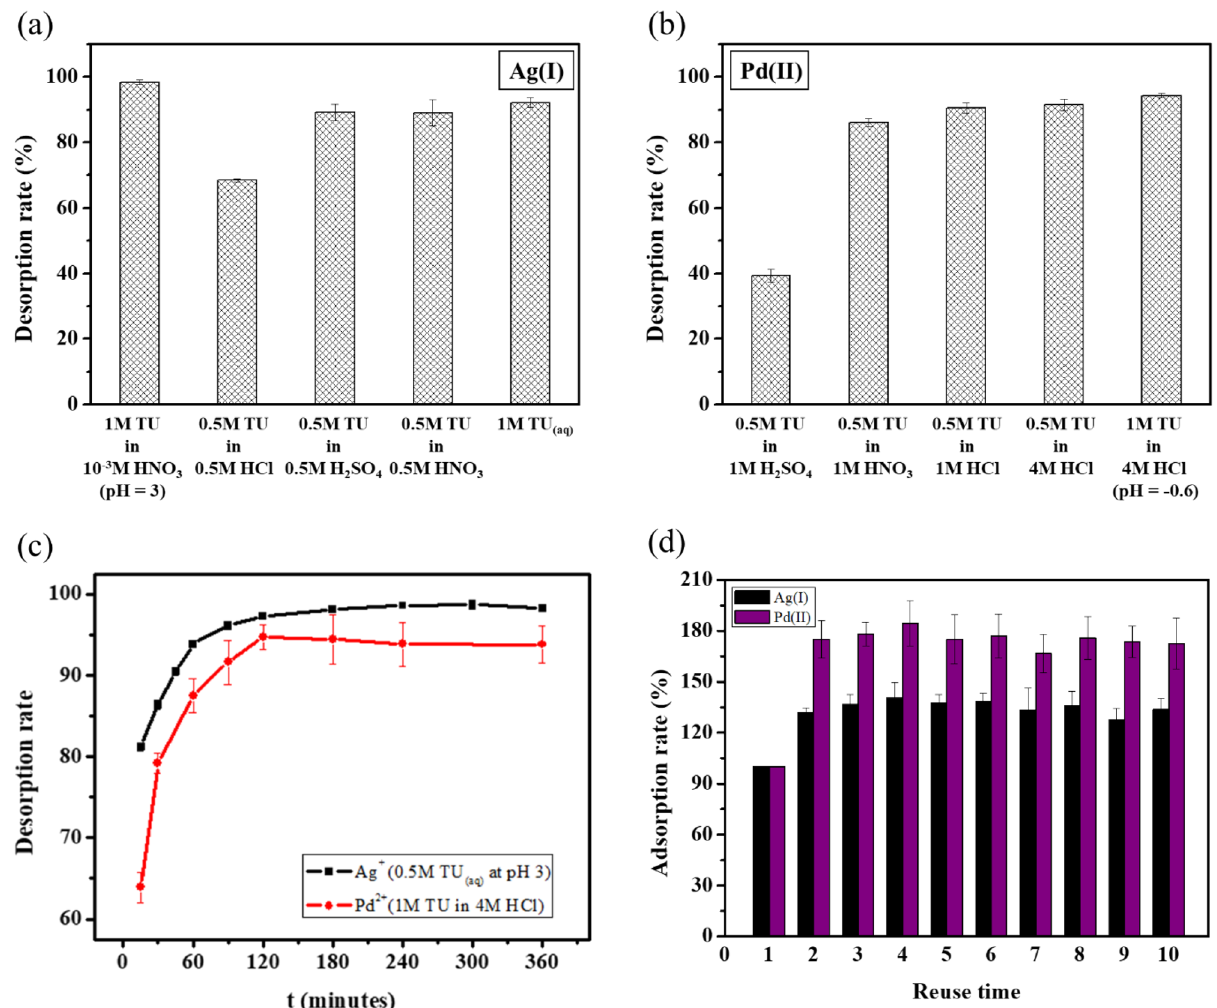
Figure 5. Desorption of ATU-PEGDA. ( a ) Using different eluents for silver ion; ( b ) using different eluents for palladium ion. ( c ) Desorption rate of spent ATU-PEGDA. The regeneration of silver ion and palladium ion were processed by 0.5 M TU at pH 3 and 1 M TU in 4 M HCl solution, respectively. ( d ) Adsorption–desorption cycle of ATU-PEGDA hydrogel adsorbents. (W = 5 mg, V = 10 mL, 25